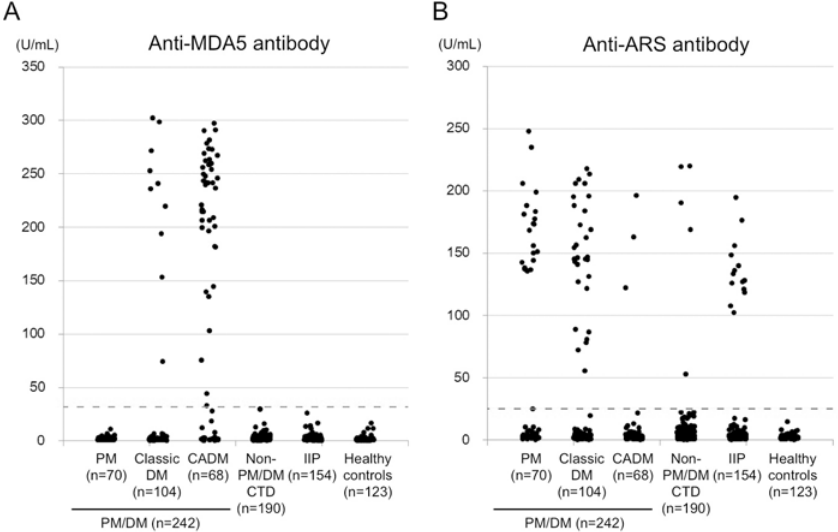
Fig 3. Anti-MDA5 (A) and anti-ARS (B) antibody levels in patients with PM/DM, non-PM/DM CTD, IIP, and healthy controls. Anti-MDA5 and anti-ARS antibodies were measured by ELISA in the sera from 242 patients with PM/DM (70 PM, 104 classic DM, and 68 CADM), 190 patients with non-PM/DM CTD, 154 patients with IIP, and 123 healthy volunteers. Cutoff levels of anti-MDA5 and anti-ARS antibodies are shown as broken lines (32 and 25 U/mL,